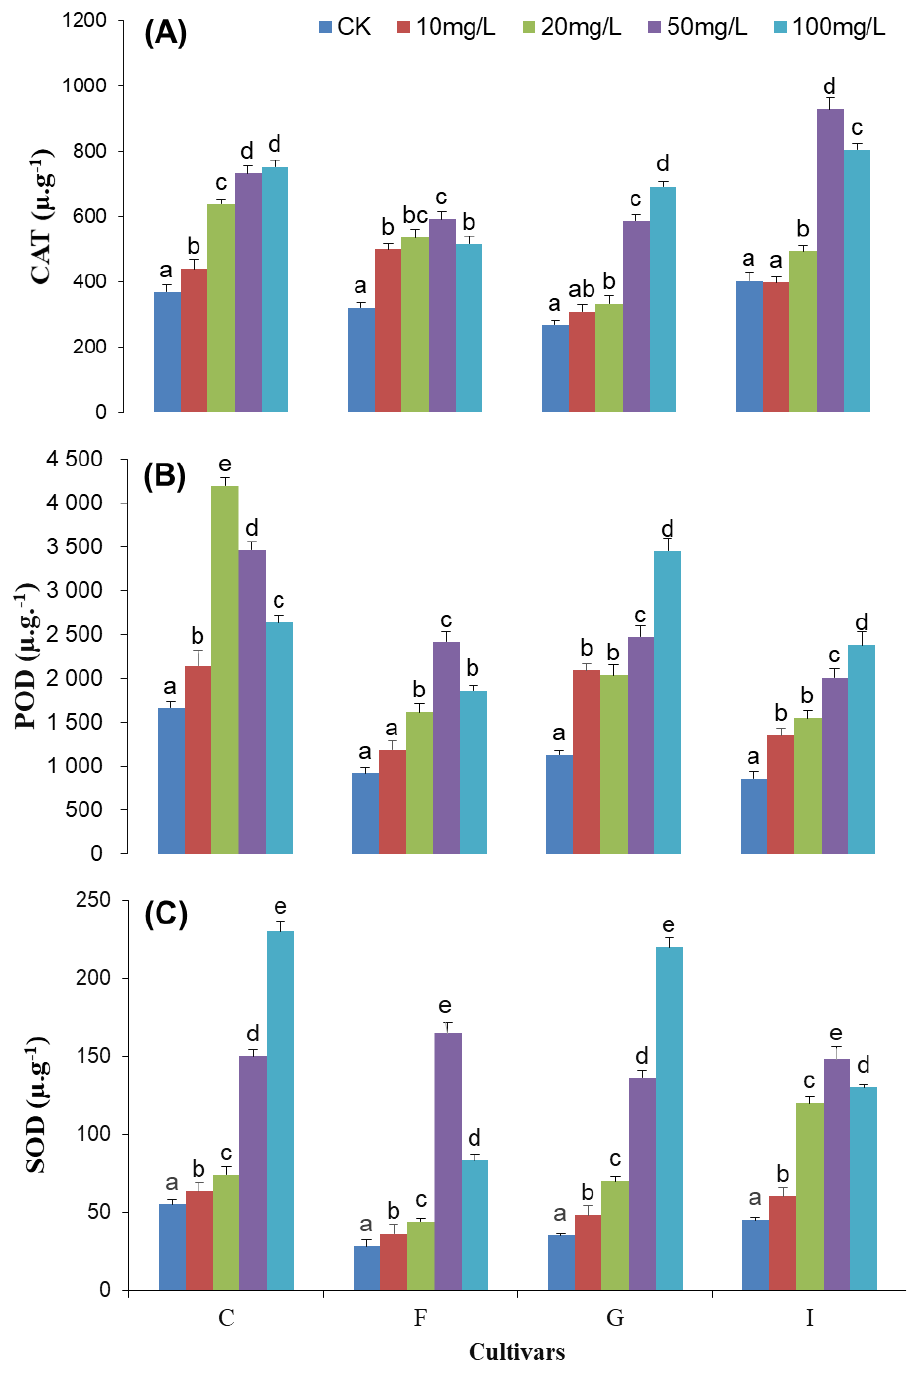
Figure 2. Antioxidant enzymes, i.e., CAT ( A ), POD ( B ), and SOD ( C ) contents of different chrysan- themum cultivars subjected to different Cd concentrations. Each value represents the mean ± S.E. from the three independent replicates ( ± , n = 3), and different statistical letters represent significant differences at the p ≤ 0.05 level.